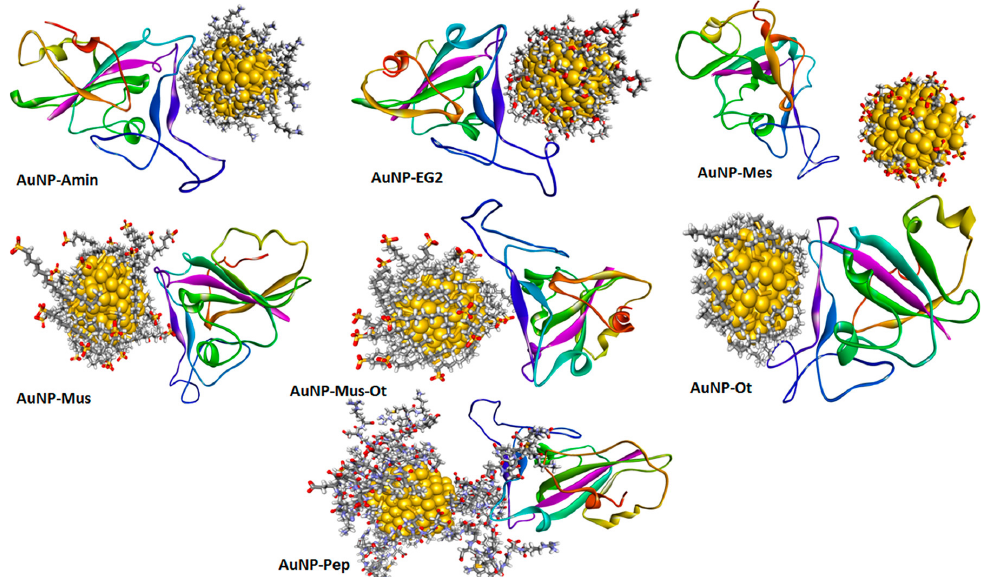
Figure 5. Simulation outcomes concerning the structures of some RBD complexes with Au NPs. Amin: 8-mercaptooctan-1-aminium; EG2: 2-(2-(6-mercaptohexyl)oxy)ethoxy)ethan-1-ol;